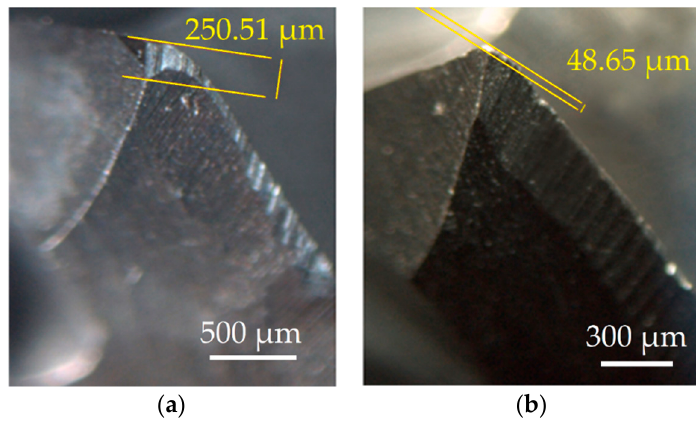
Figure 10. Dependence of the wear chamfer size on the flank surface of the end mills on the operating time when machining the aluminum alloy AlCuMg2 with end mills with different coatings.